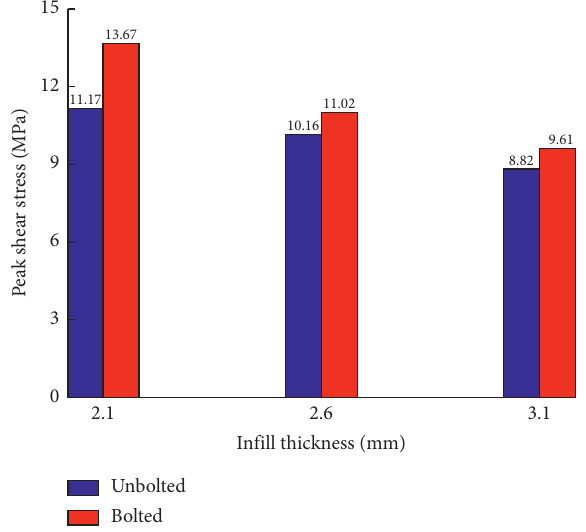
Figure 19: Relationship between peak shear stress and infill